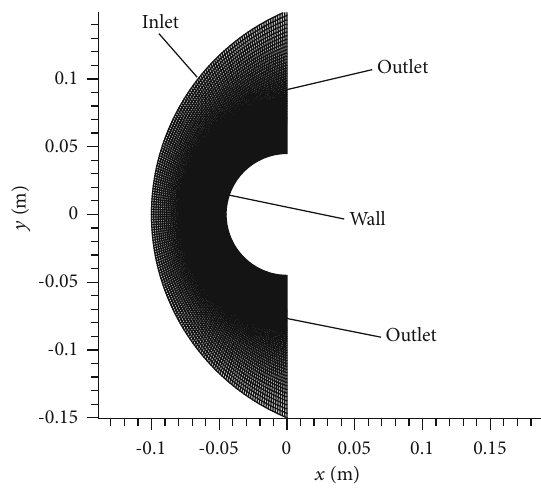
Figure 6: The computational grid.